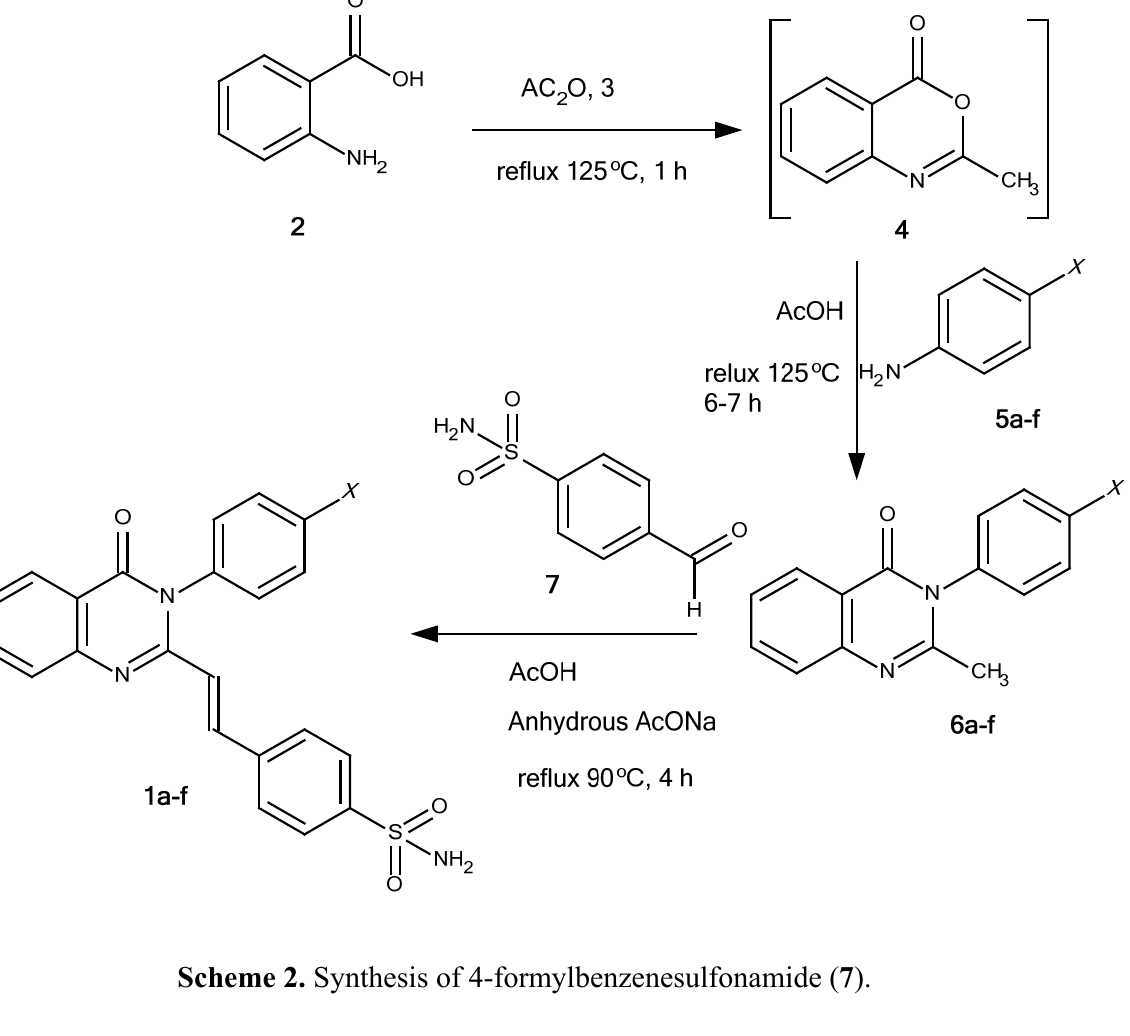
Scheme 1. Synthesis of the title compounds 1a-f